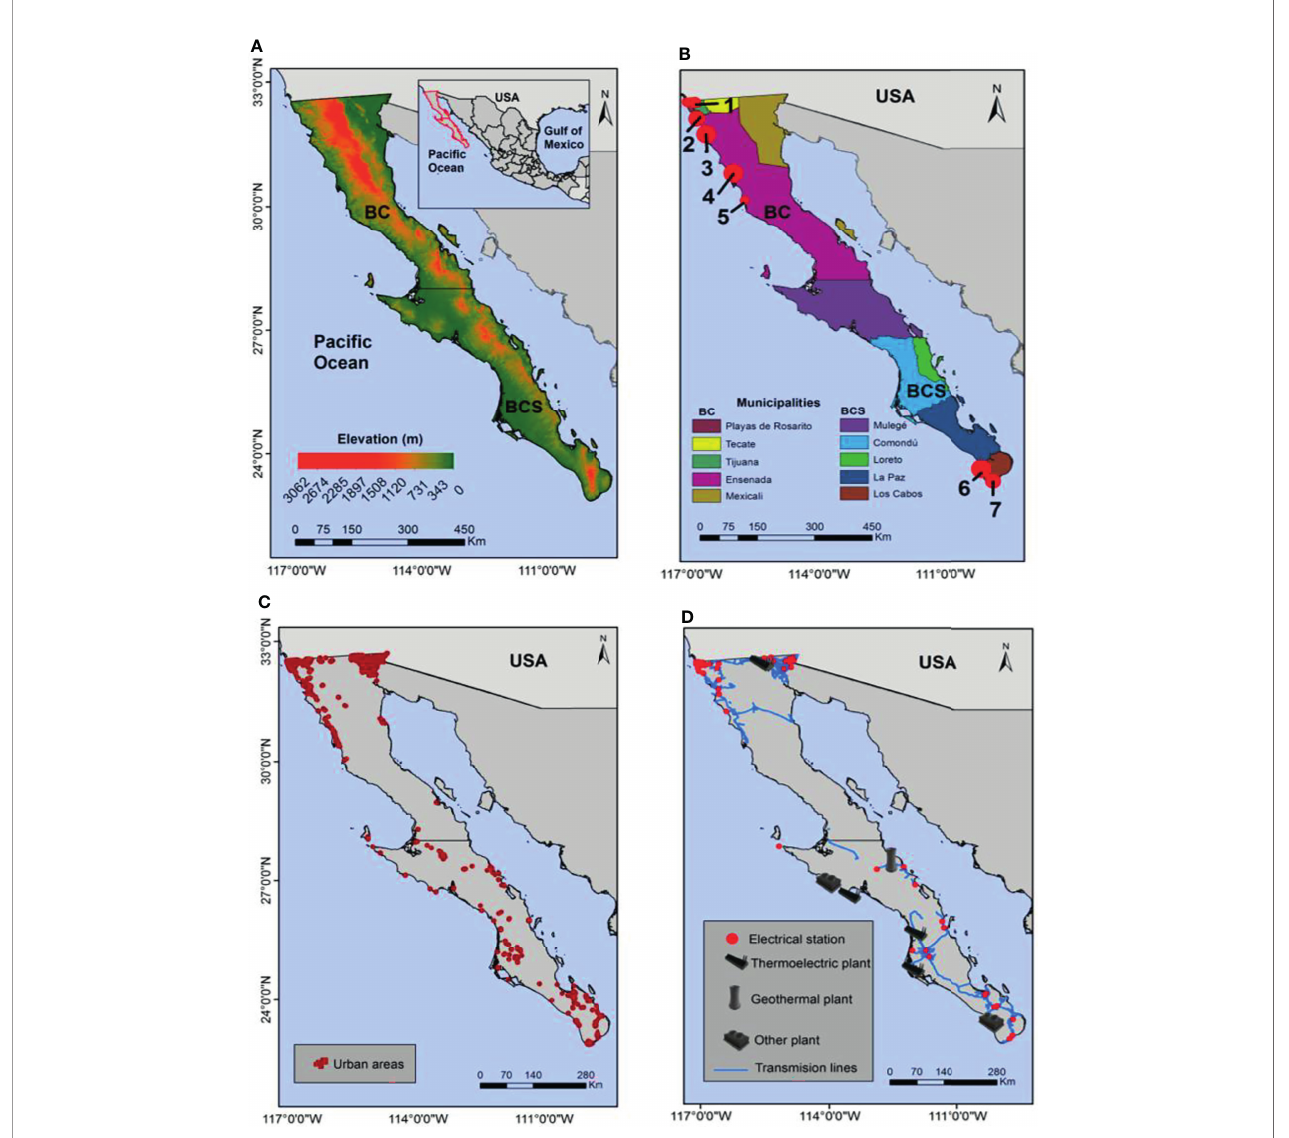
FIGURE 1 | (A) Location of the Mexican states of Baja California (BC) and Baja California Sur (BCS). (B) Municipalities and the most populated coastal settlements (>3 000 inhabitants): 1. Tijuana, 2. Santa Anita, 3. Coronel Esteban Cantu ́ , 4. San Ramo ́ n, 5. El Rosario de Abajo, 6. Ejido Plutarco El ı ́ as Calles, and 7. Residencial Amal fi d). (C) Urban areas (>800 inhabitants). (D) Electricity networks in the peninsula. Data from INEGI